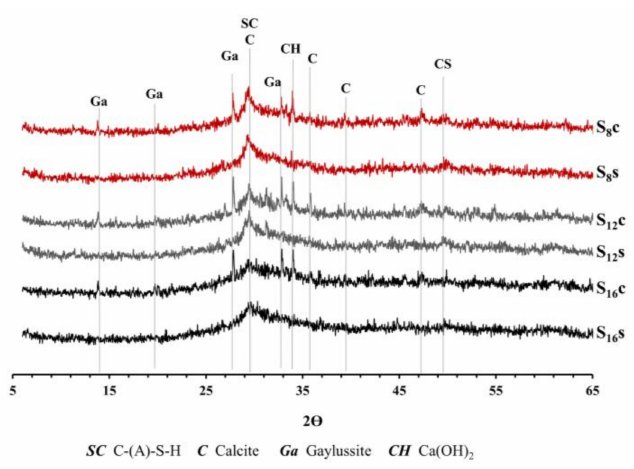
Figure 6. XRD results of the AAS pastes after 28 d of sealed curing at 21 ± 2 ◦ C and 35 ± 5%